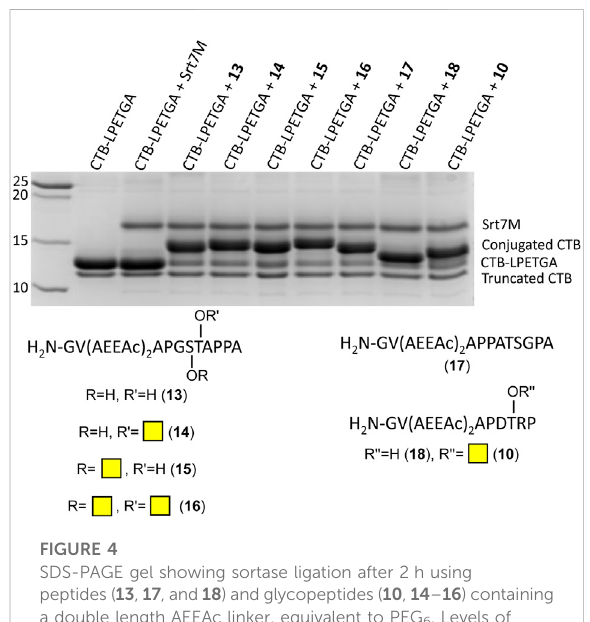
FIGURE 4 SDS-PAGE gel showing sortase ligation after 2 h using peptides ( 13 , 17 , and 18 ) and glycopeptides ( 10 , 14 – 16 ) containing a double length AEEAc linker, equivalent to PEG 6 . Levels of conjugation listed in Table 1.